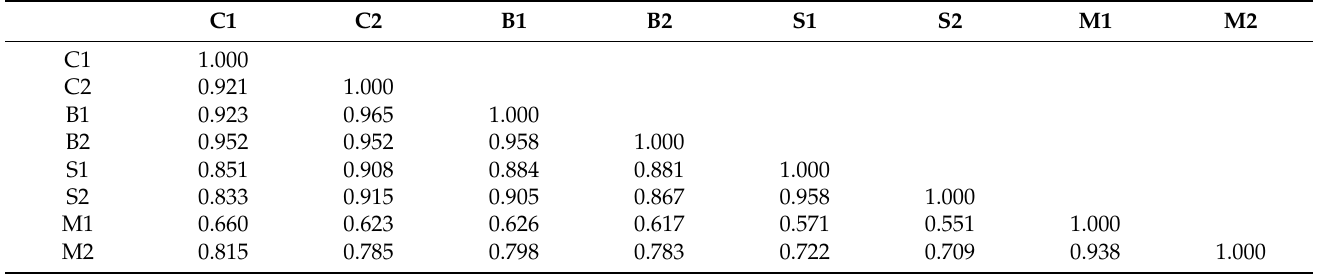
Table 5. A correlation matrix of positioning bias per GNSS correction and their repetitions.